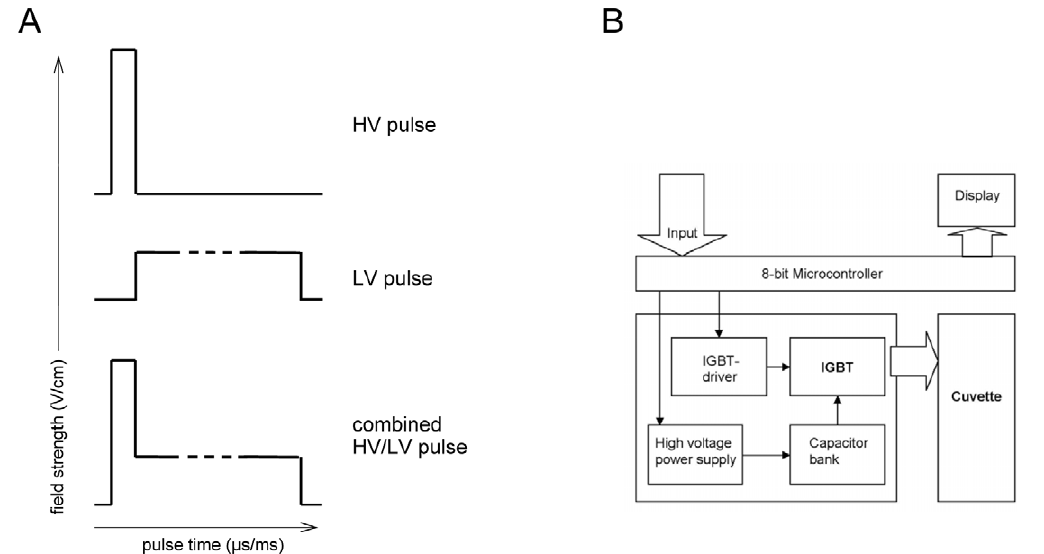
Figure 1. Definition of square wave pulses for eukaryotic cell transfection generated by the ELPorator 1000 device. (A) The ELPorator 1000 device consisting of two physically independent but electrically interconnectable modules. Module 1 produces single HV square wave pulse at a maximum field strength of 5 kV/cm for 1–999 m s. Module 2 provides a single LV square wave pulse with up to 1.5 kV/cm in the range of milliseconds. Combination of HV and LV square wave pulses forms an uninterrupted combined pulse. Preferentially, a LV pulse follows a primary HV pulse. Within the ranges noted above, parameters of single or combined pulses can be defined individually. (B) Flow chart of input and output parameters within the electronic components of the individual